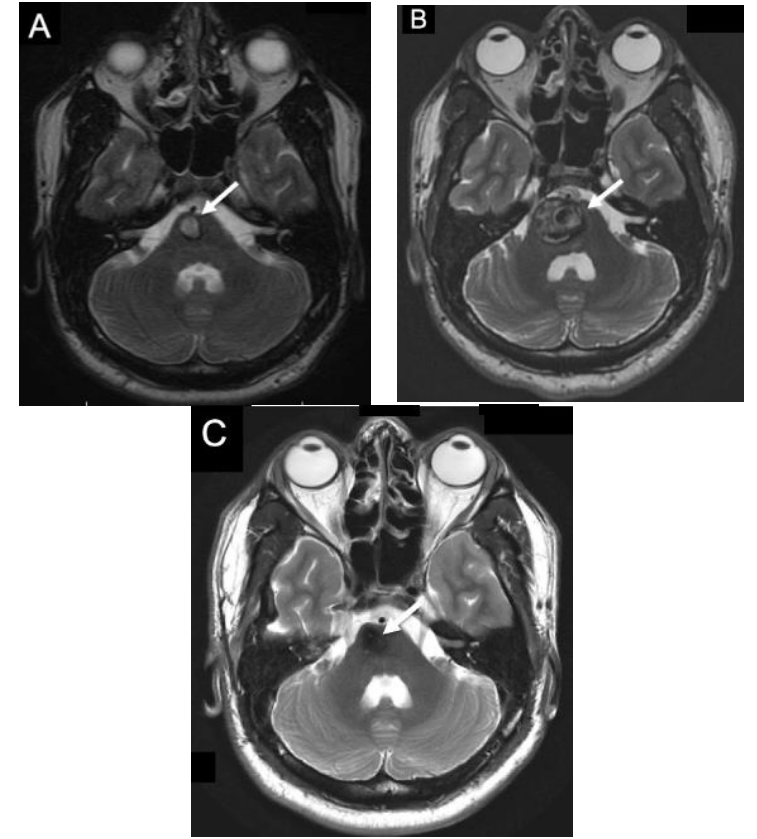
Figure 5. Operative Brainstem Lesion. T2 axial MRI of a 27-year-old male patient found initially to have a pontine CCM (( A ), white arrow). He experienced two hemorrhagic events in a 6-month period resulting in left sided weakness, numbness, and slurred speech with enlargement and hemorrhage into the lesion seen on T2 MRI ( B ). He was taken for complete resection of the lesion one month after the second hemorrhagic event via a trans-petrosal approach with resolution of brainstem compression. The patient had progressive recovery over the following 6 months at which time a T2 MRI showed no residual CCM ( C ).